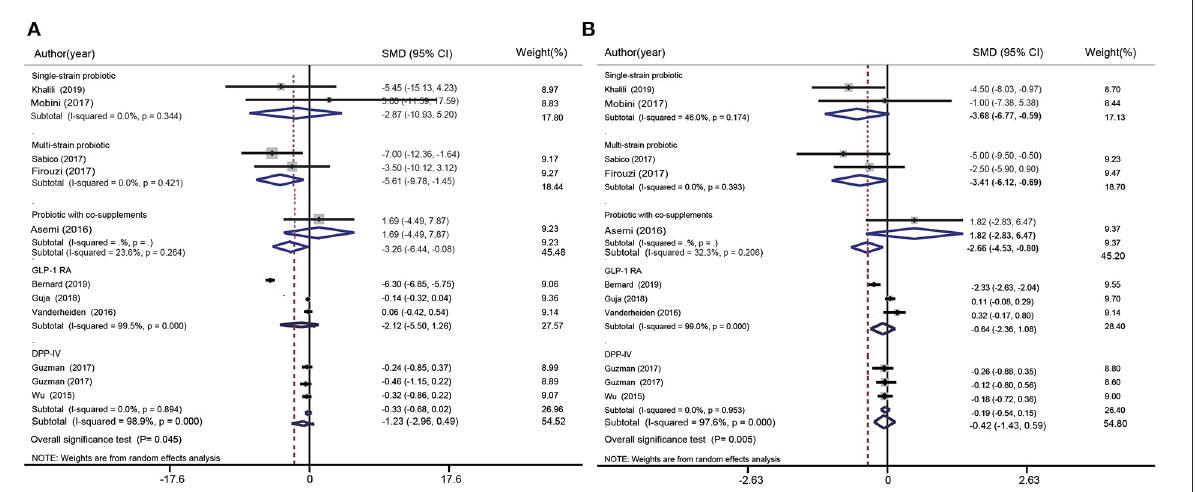
FIGURE5 Forest plot for the effect of probiotics supplementation and glucose-lowering drugs on SBP (mmHg) (A) and DBP (mmHg) (B) compared to placebo. For each study, the solid black diamonds represent the point estimate of the intervention effect. The horizontal line joins the lower and upper limits of the 95% CI of this effect. The open diamonds represent the subgroup and overall SMD determined with a random-effects